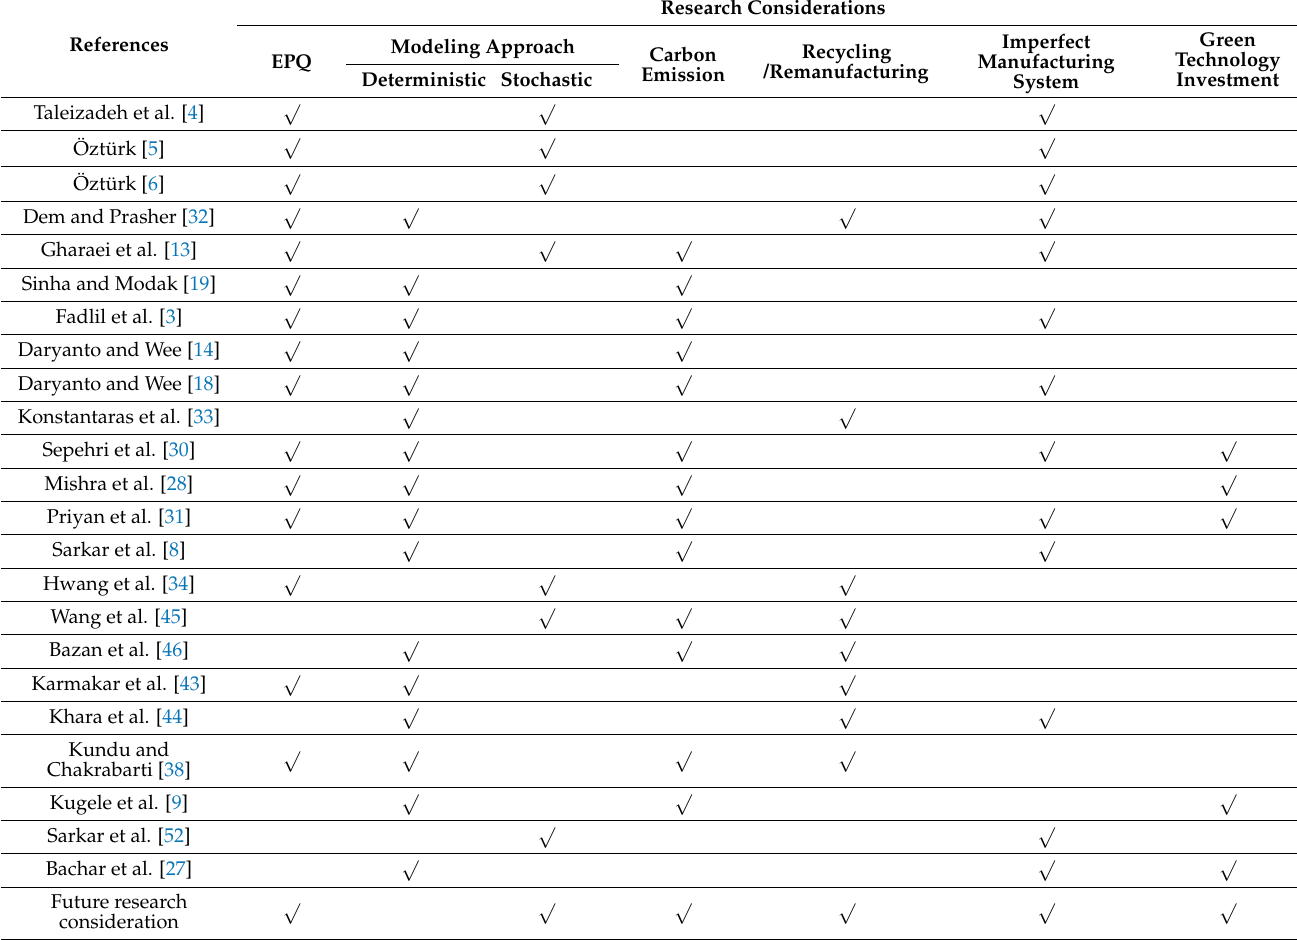
Table 1. Major findings from the literature survey.